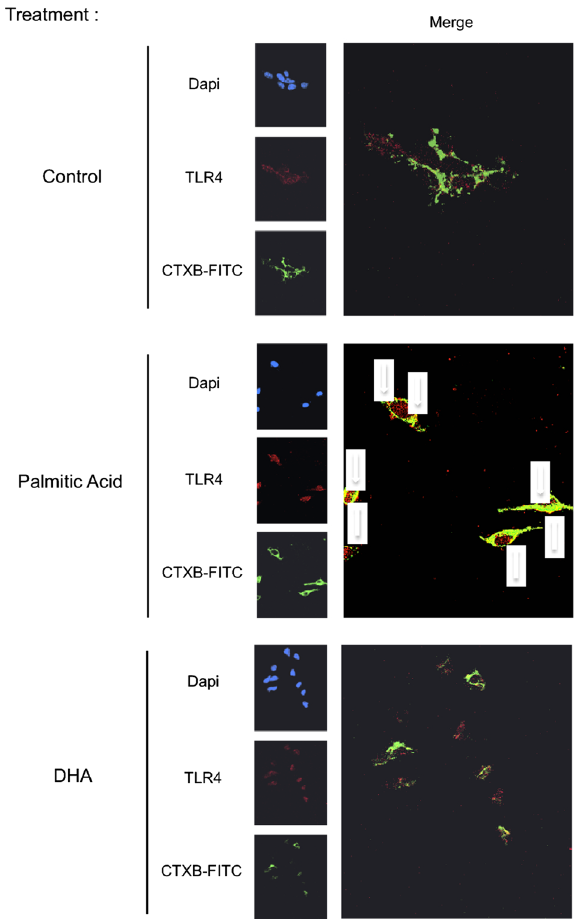
Figure 5. Palmitic acid induced TLR4 recruitment to membrane lipid rafts. Human SH-SY5Y cells were treated with palmitic acid, DHA or placebo during 4 h and fixed for immunohistochemistry analysis by confocal microscopy using antibodies directed towards CTXB (marker of membrane lipid rafts) or TLR4. The arrow in the merge indicated the co-localization of TLR4 and CTXB. Images were captured using a confocal microscope with high-magnification scan (X40). The figure is representative of two biological replicates and each image resulted from several slides that were analyzed by confocal